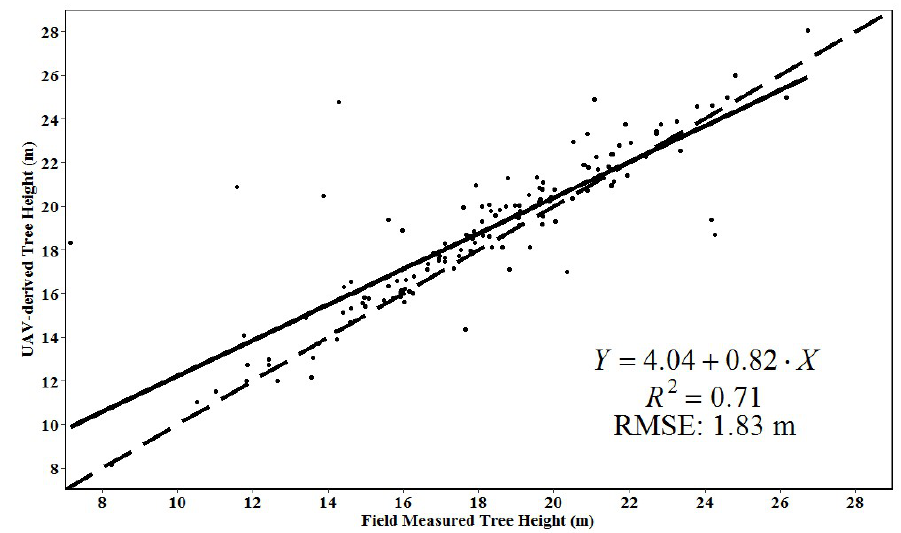
Figure 4. Linear regression model between the UAV image-derived and field-measured individual tree heights. The solid line represents the fitted regression line and the dashed line is a 1:1 line for reference.